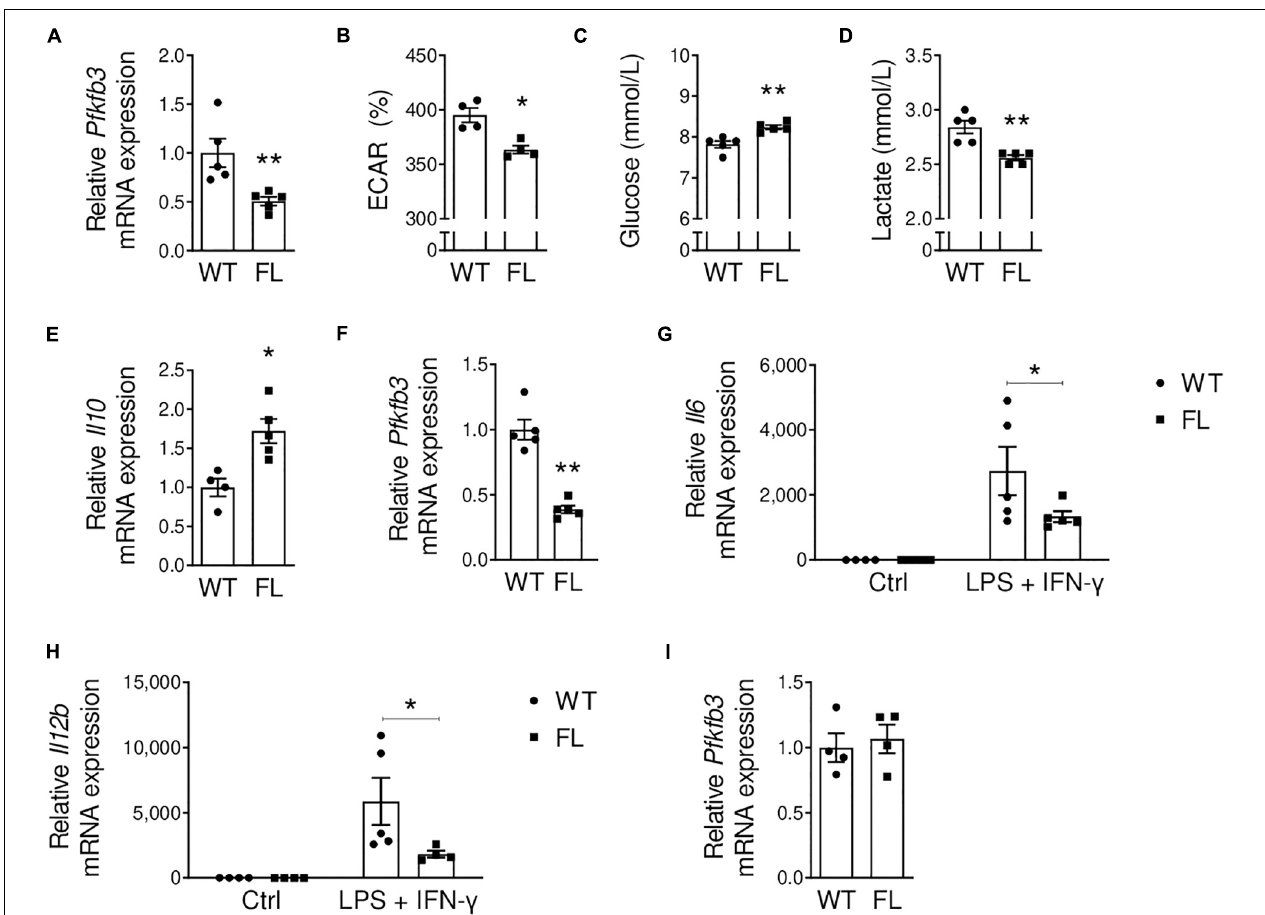
FIGURE 2 | Decreased Pfkfb3 expression and decreased glycolysis in Pfkfb3 fl / fl bone marrow-derived macrophages. (A) Pfkfb3 mRNA expression in Pfkfb3 fl / fl (FL) relative to Pfkfb3 wt / wt (WT) bone marrow-derived macrophages (BMDM). (B) Extracellular acidification rate (ECAR, percentage of baseline) of Pfkfb3 fl / fl and Pfkfb3 wt / wt BMDMs after 10 mM glucose stimulus, as assessed with a Seahorse XF Analyzer. (C) Glucose and (D) lactate levels in Pfkfb3 fl / fl and Pfkfb3 wt / wt BMDM culture media after 26 h of culture. (E) Il10 mRNA expression in unstimulated Pfkfb3 fl / fl relative to Pfkfb3 wt / wt BMDMs. (F) Pfkfb3 mRNA expression in Pfkfb3 fl / fl relative to Pfkfb3 wt / wt BMDMs after pro-inflammatory stimulation with LPS and IFN- γ . (G) Il6 and (H) Il12b mRNA expression in Pfkfb3 fl / fl and Pfkfb3 wt / wt BMDMs cultured without additions (ctrl; control) or stimulated with LPS and IFN- γ . Expression is relative to unstimulated Pfkfb3 wt / wt BMDMs. (I) Pfkfb3 mRNA expression in Pfkfb3 fl / fl relative to Pfkfb3 wt / wt bone marrow-derived dendritic cells. The graphs represent mean ± SEM. * p < 0.05, ** p < 0.01. Data were analyzed using Mann-Whitney U test. ECAR; extracellular acidification